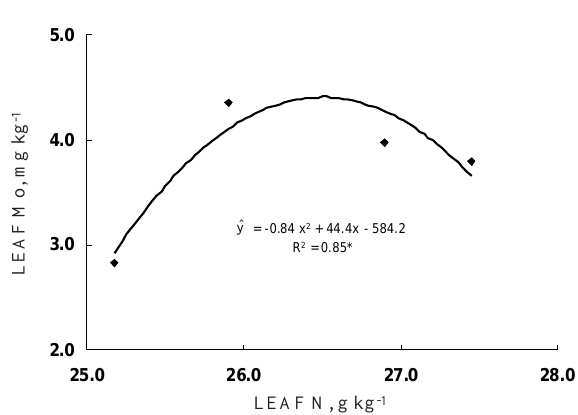
Figure 3. Relationship between leaf N and Leaf Mo in peanut crop established in four lime rates, averaged in three successive harvests. (Data for Mo rates were averaged) * significant at 0.05 probability.